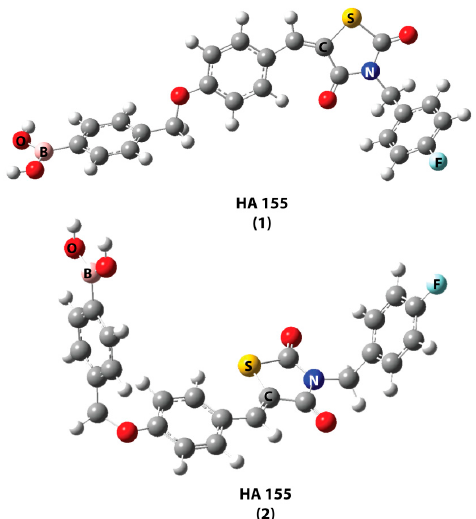
Figure 4. Optimized geometries of inhibitor HA155, a local minima conformer ( 1 ) and a global minima crystal structure conformer ( 2 ), at the B3LYP/6-31+G(d,p) level of theory.